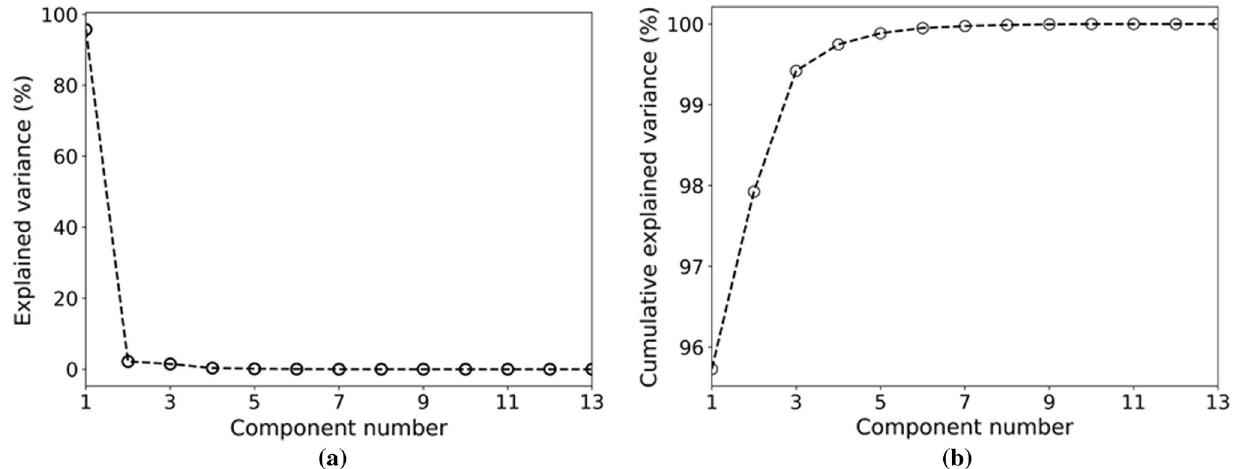
Fig. 7 The results of PCA in terms of a individual variance and b cumulative variance, explained by the principal components